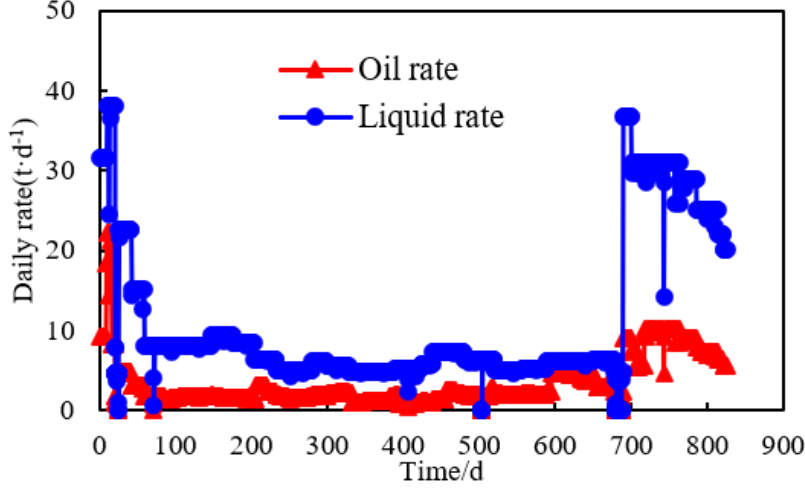
Figure 12. Production curve after refracturing.